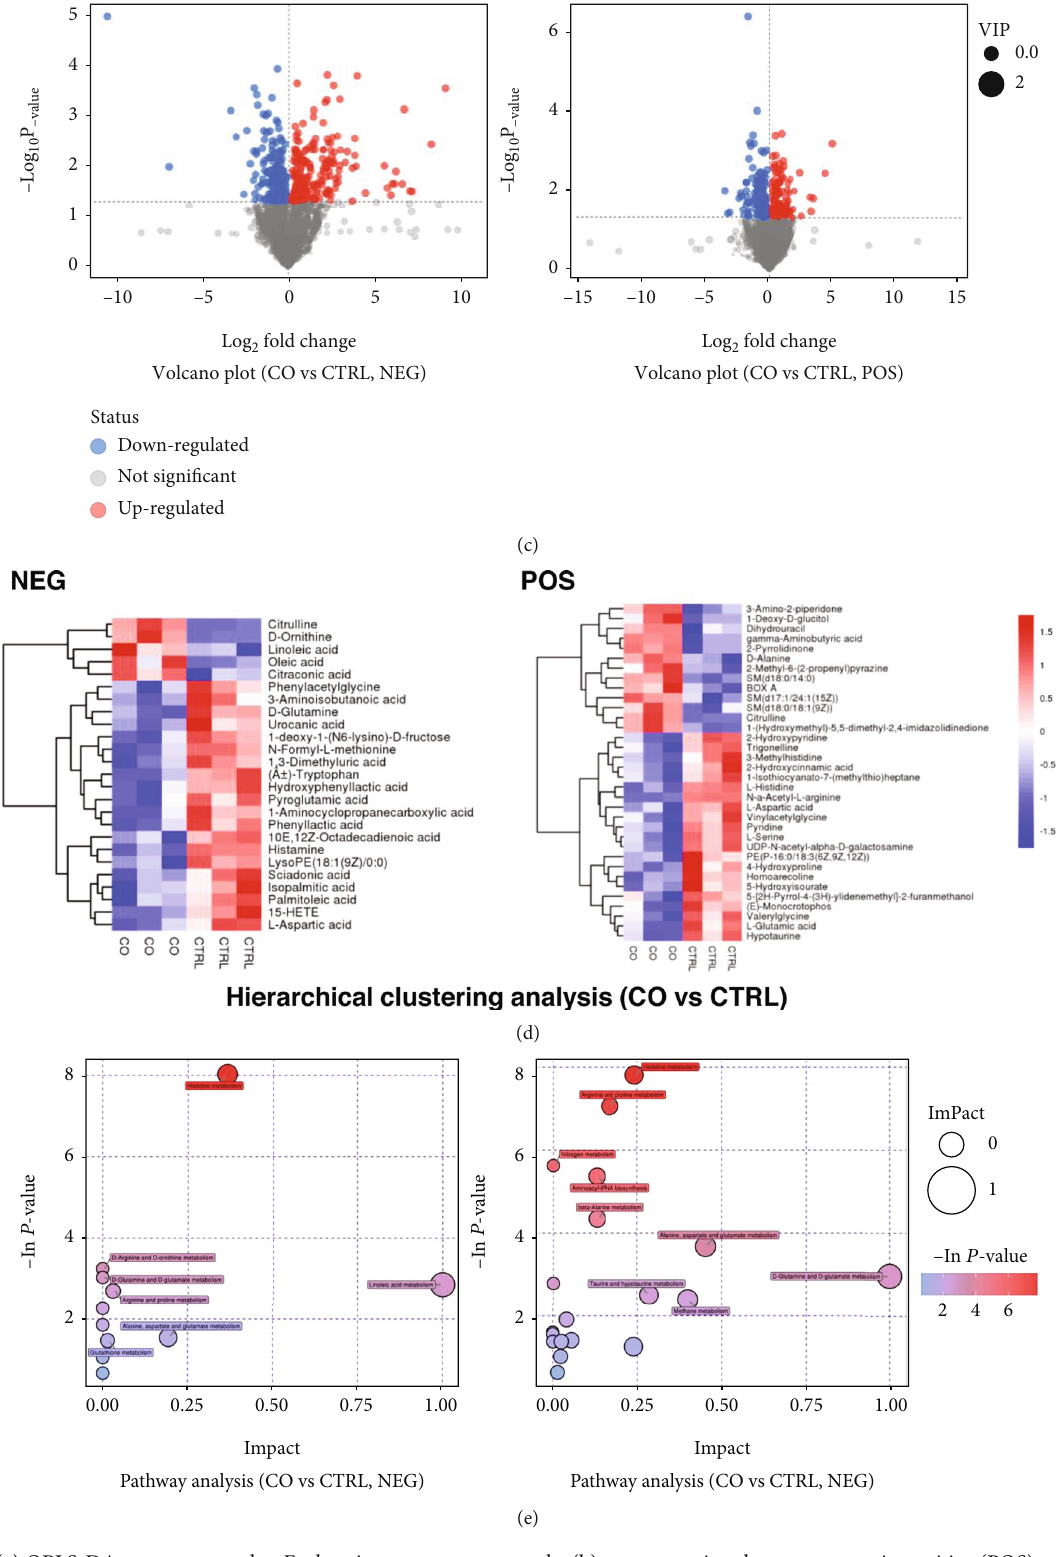
Figure 2: (a) OPLS-DA score scatter plot. Each point represents a sample; (b) representative chromatograms in positive (POS) and negative (NEG) ion modes; (c) volcano plot of di ff erential metabolite analysis. The dotted line indicates the threshold of the di ff erential metabolites selected; (d) cluster analysis of di ff erential metabolites; (e) pathway